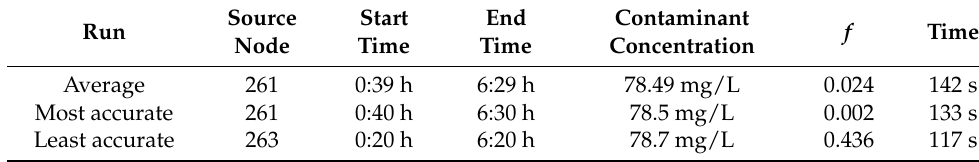
Table 4. Framework 1 results for the NET3